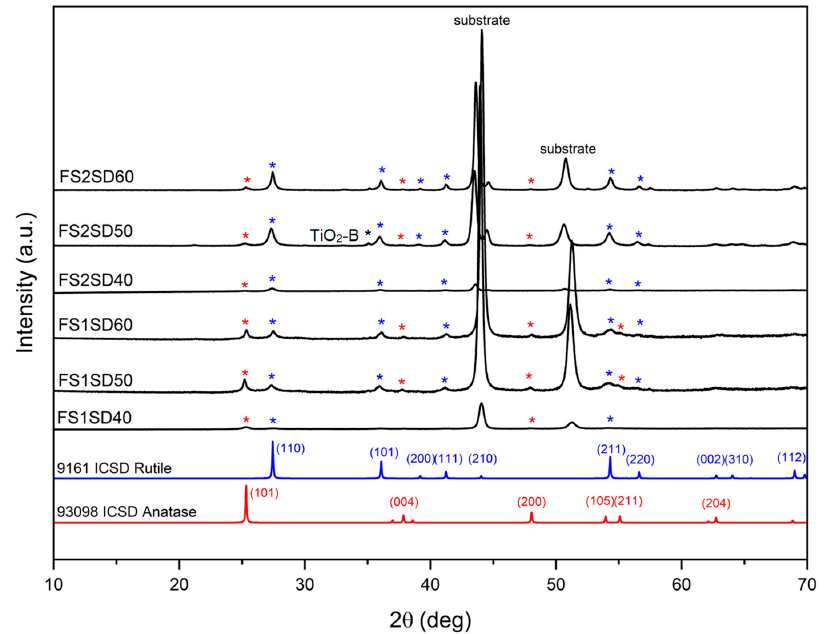
Figure 7. XRD of SPPS TiO 2 coatings derived from full-pass sprayed (0.3 M) TiO 2 solution at different stand-off distances. (The red, blue and black asterisks (*) correspond to the signature peaks of anatase TiO 2 , rutile TiO 2 and TiO 2 -B, respectively, which are visible in each pattern when plotted individually).